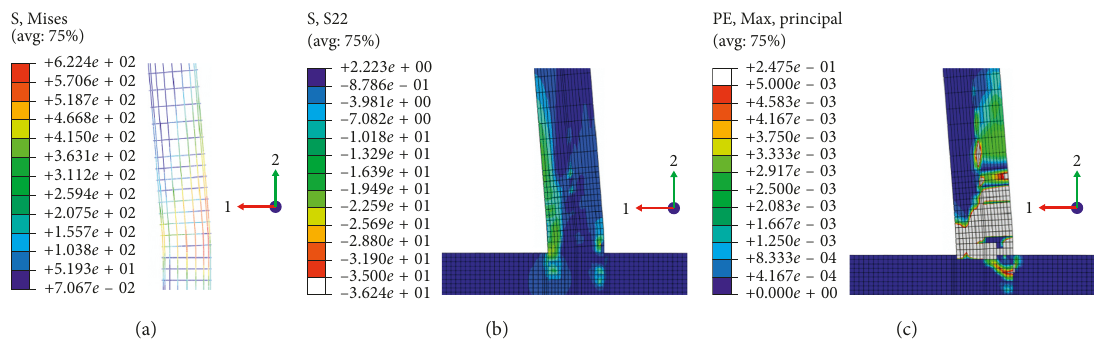
Figure 19: F-HMSB at the final stage (7.91%): (a) reinforcement stress distributions; (b) concrete stress distributions; and (c) concrete